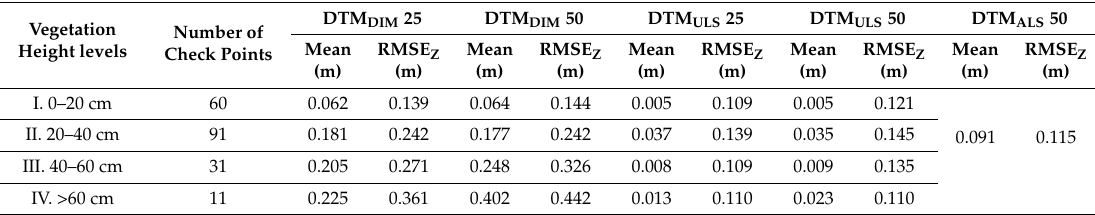
Table 3. Vertical accuracy assessment of digital terrain models (DTMs), based on the reference geodetic field measurements (GNSS-RTK check points).